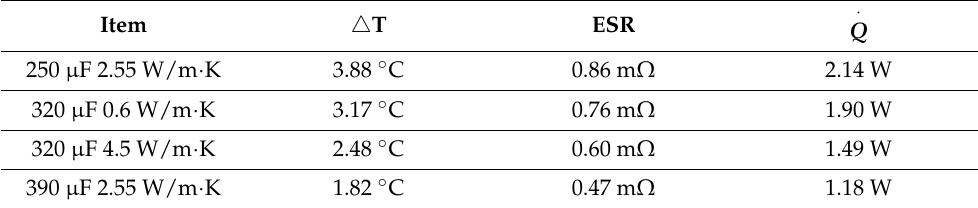
Table 6. Analysis results for film thickness 3.5 µ m.